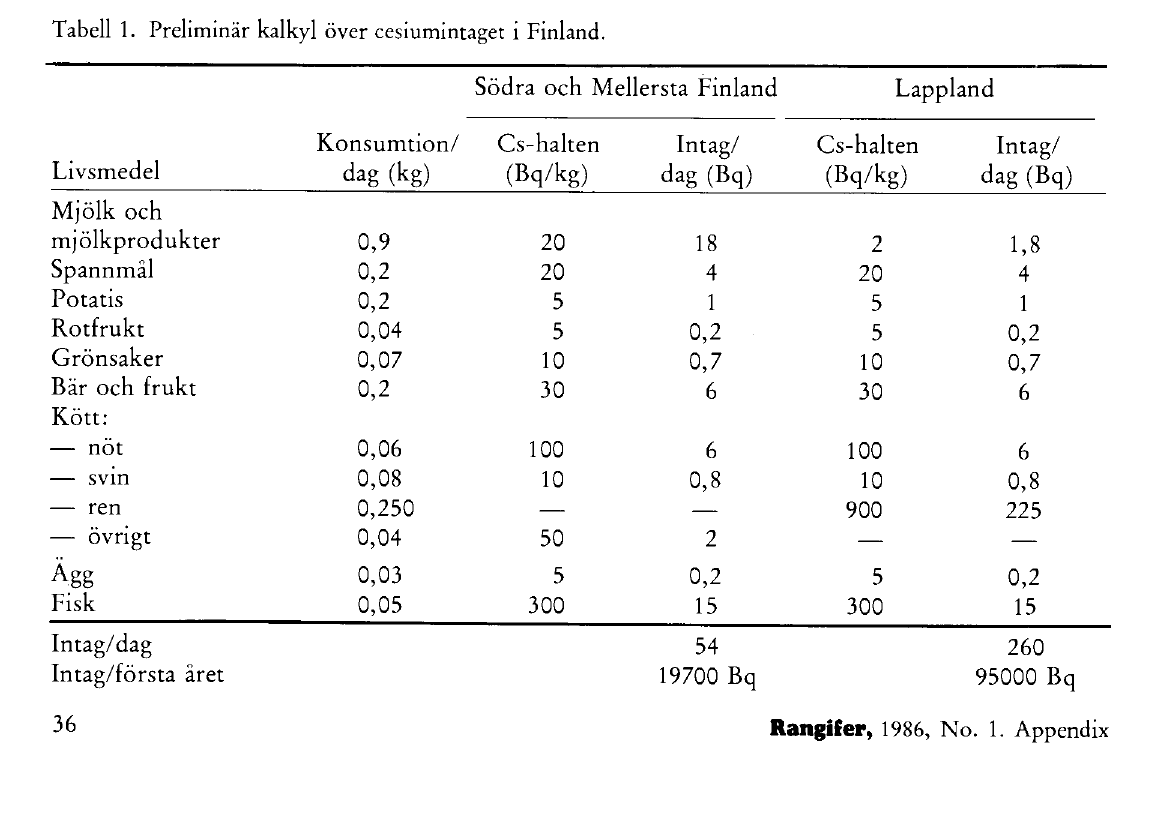
Tabell 1. Preliminår kalkyl over cesiumintaget i